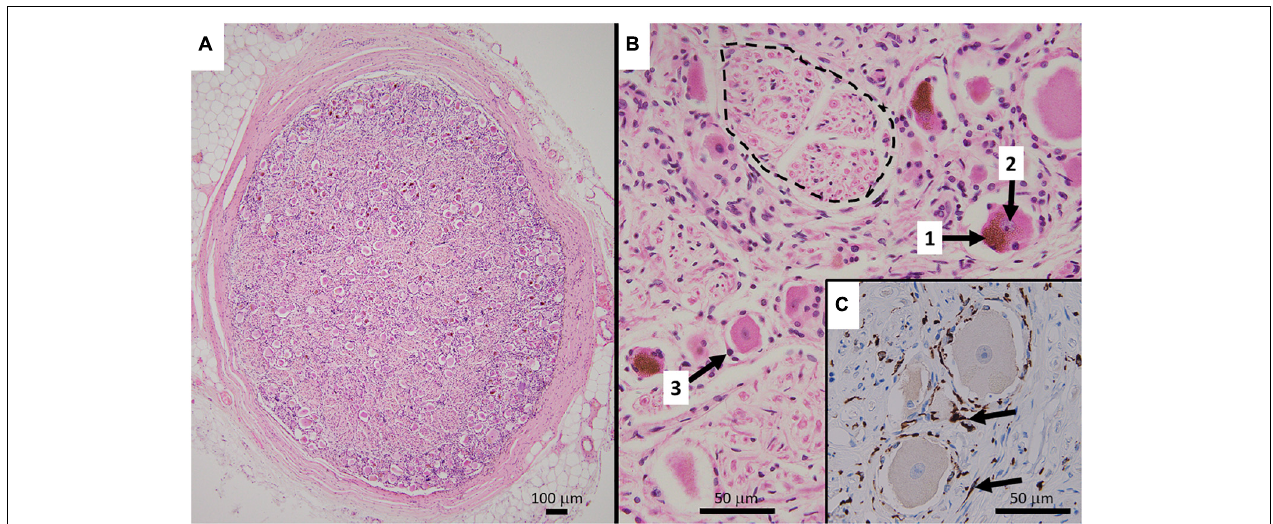
FIGURE 1 | (A) Representative HE stained micrograph section of a thoracic human DRG (medical dissection course, ethics approval obtained from The Southern Adelaide Clinical Human Research Ethics Committee, OFR no.: 55.17) with a thick protective layer of connective tissue demonstrating the predominant localization of cell bodies in the periphery of the ovoid DRG cross-section. (B) Cell bodies of sensory neurons containing lipofuszin (1) and a nucleus with a prominent nucleolus (2), surrounded by satellite cells (3). Bundles of nerve fibers (dashed line) are predominantly present in the center of the ganglion. The HE staining method results in shrinkage of the cell bodies which disconnects them from the layer of satellite cells. (C) Immunohistochemistry micrograph for CD163 with counterstaining for hematoxylin shows the presence and distribution of macrophages (arrows) in DRG.